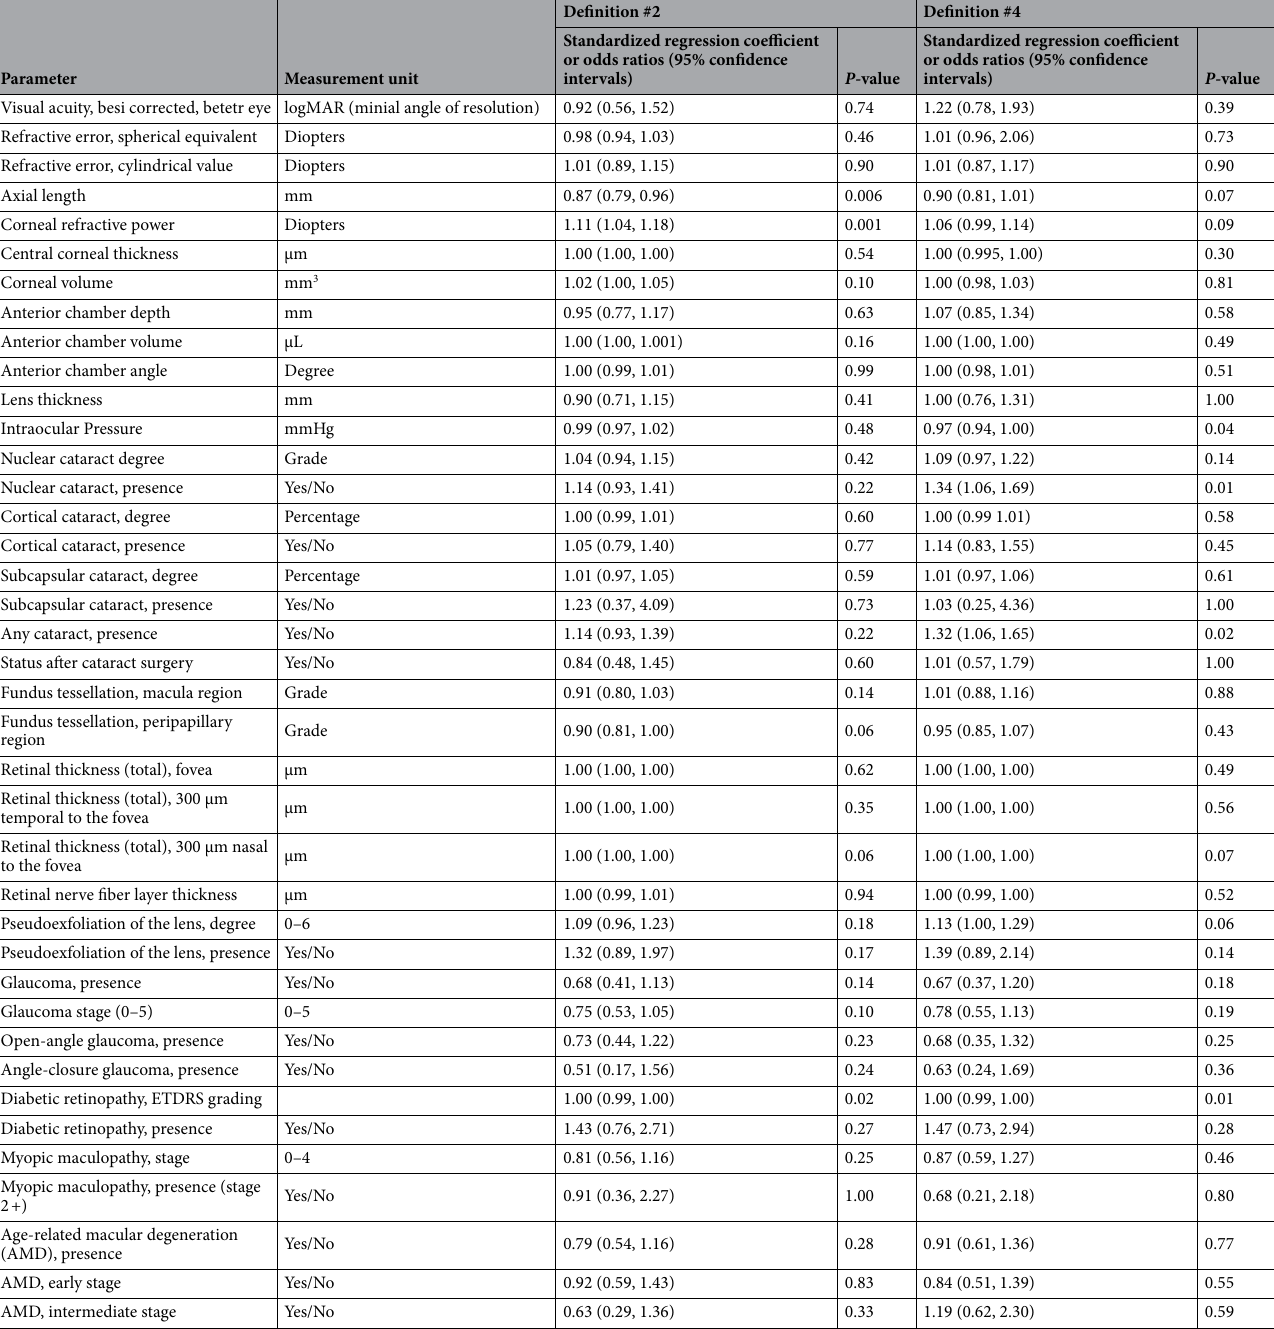
Table 4. Associations (binary univariable analysis) between the prevalence of dry eye disease using definition #2 (dry eye symptoms score was ≥ 2 and Schirmer´s test of < 5 mm) or definition #4 (dry eye symptoms score was ≥ 1, Schirmer test ≤ 5 mm, and a Meibomian gland dysfunction grade of 1 (telangiectasia at the lid margin) or higher) with ocular parameters in the Ural Eye and Medical